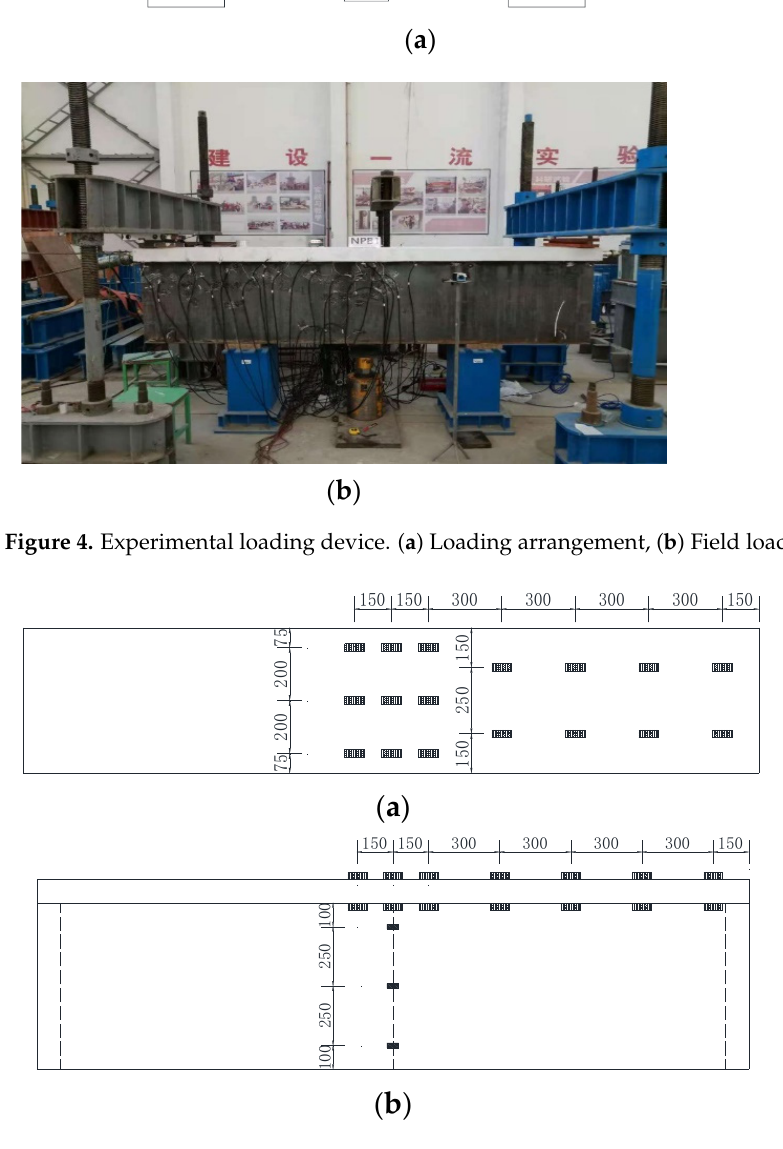
Figure 4. Experimental loading device. ( a ) Loading arrangement, ( b ) Field loading diagram.